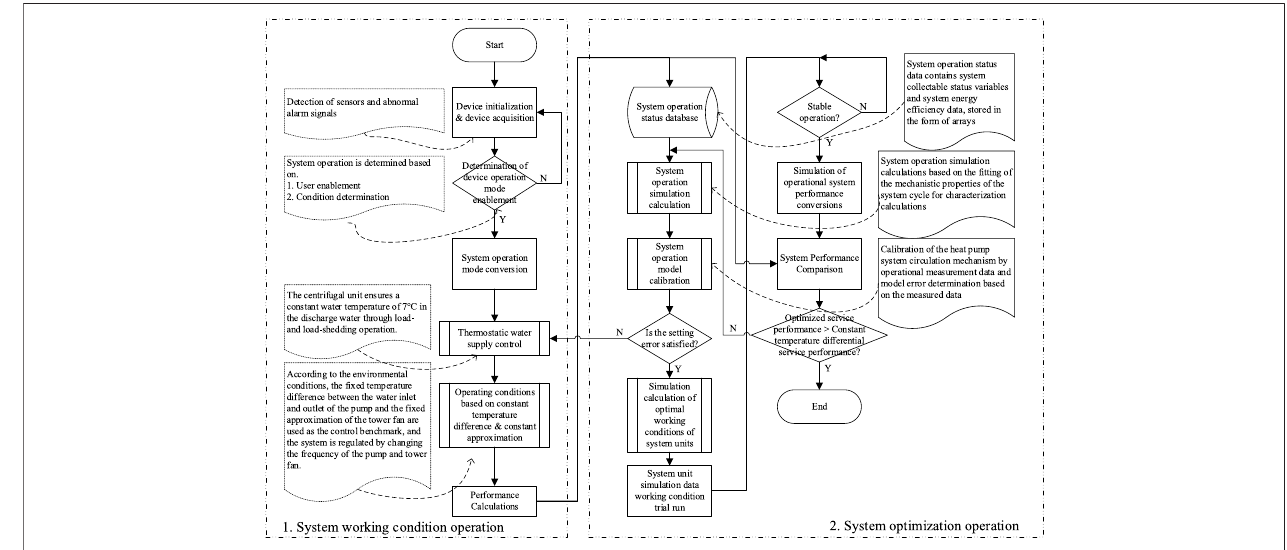
FIGURE 7 | Data analysis running process.